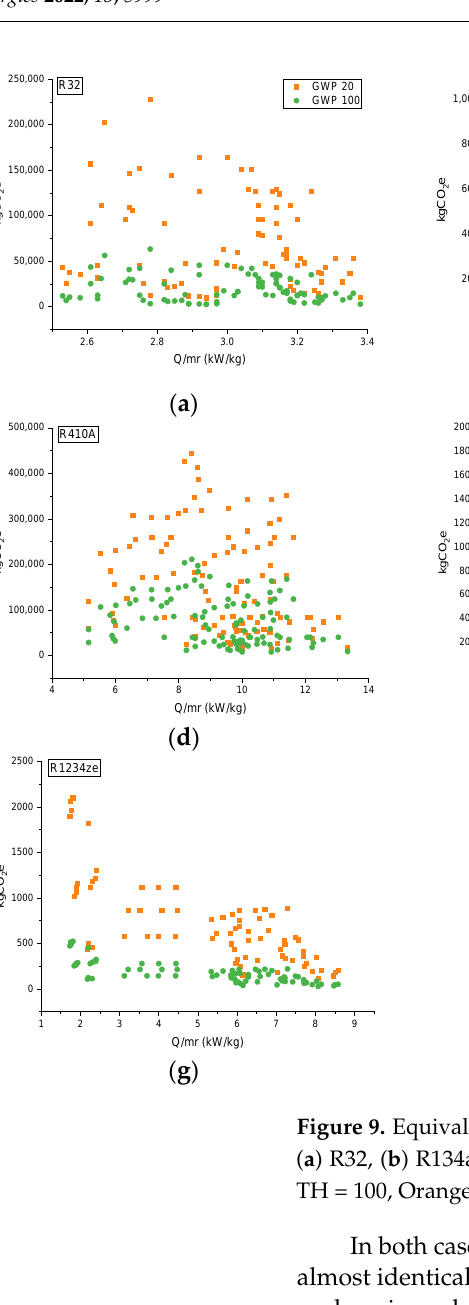
Table 7. Transport and physical properties for R410A and its substituents.